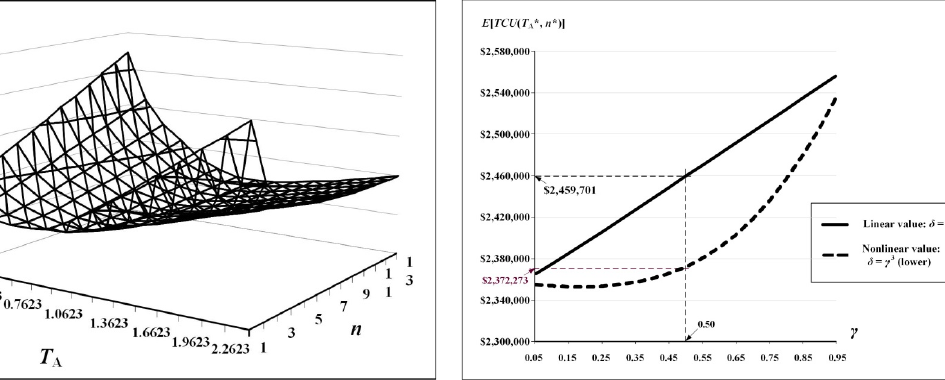
Fig. 6. The behavior E [ TCU ( T A *, n *)] regarding linear and nonlinear relationships of δ and γ